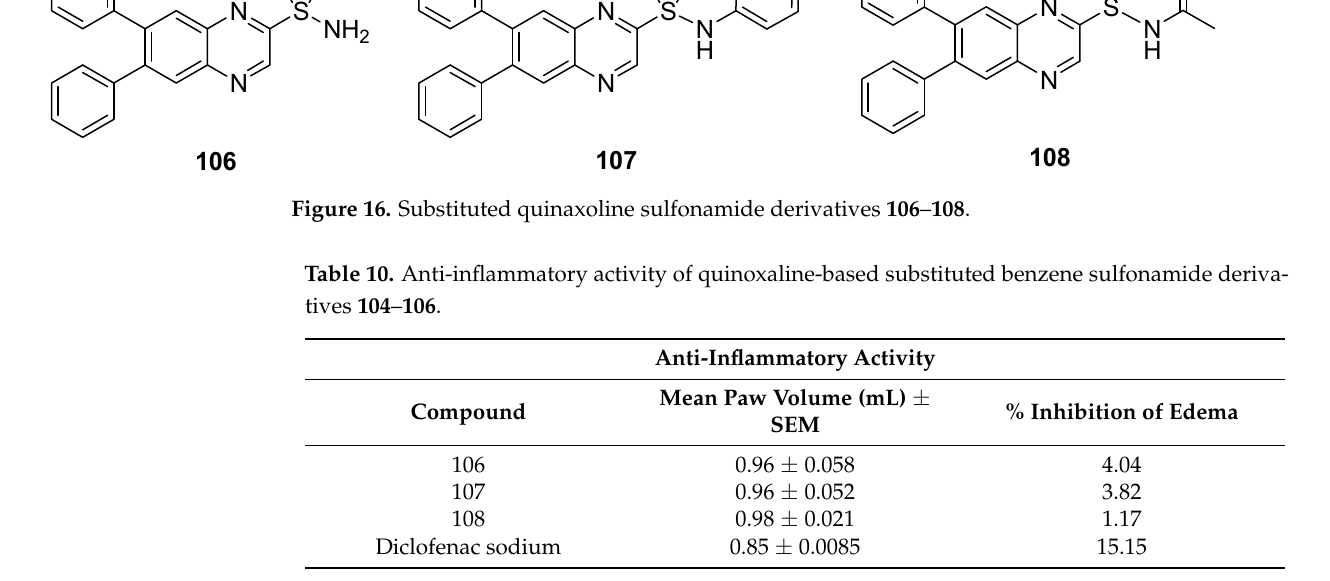
19 of 25 Figure 15. Substituted quinoxaline sulfonamide derivatives 103–104 . 2.6. Synthesis of Quinoxaline-Based Benzene Sulfonamide Derivatives with Anti-Inflammatory Activity The property of a substance or drug that reduces inflammation or swelling is speci- fied as anti-inflammatory. In other words, nonsteroidal anti-inflammatory drugs (NSAIDs) are drugs that help reduce inflammation, which often helps to relieve pain. NSAIDs can be very effective, and some of the NSAIDS are high-dose aspirin, ibuprofen (Advil, Motrin, Midol) and naproxen (Aleve, Naprosyn), etc. Ingle et al. synthesized novel quinoxaline sulfonamide derivatives and described their anti-inflammatory activity. The sulfonation of 2,3 diphenylquinoxaline 56 was car- ried out by the electrophilic agent 47 to produce quinoxaline sulfonyl chloride 57 at 76% yield that was further treated with aliphatic and aromatic substituted amines to obtain the final quinoxaline sulfonamides 105 at 59–85% yield (Scheme 11) [137]. 5756 47